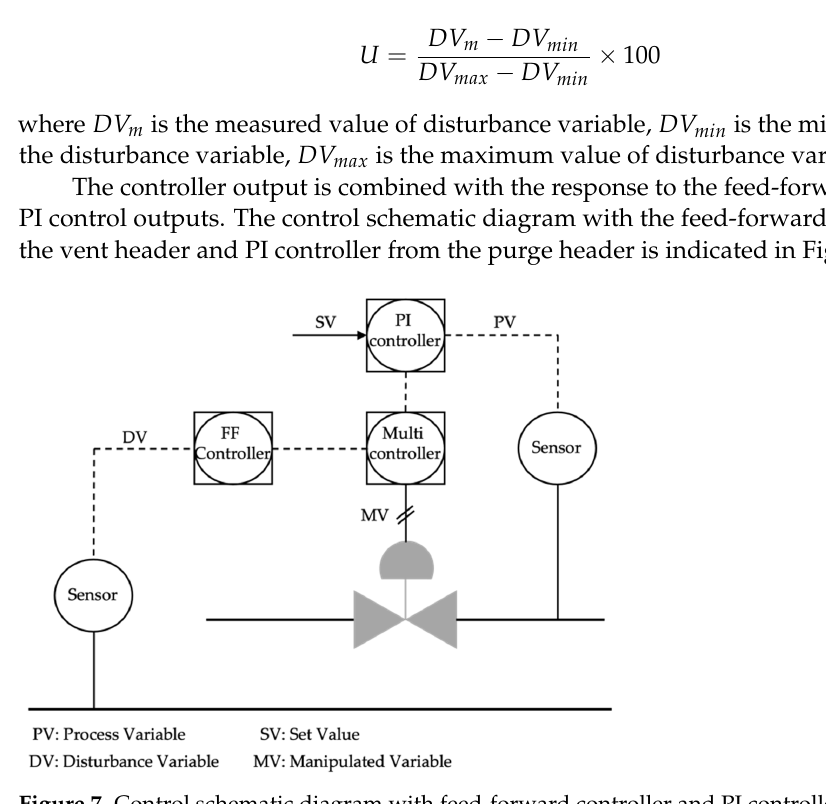
Figure 7. Control schematic diagram with feed-forward controller and PI